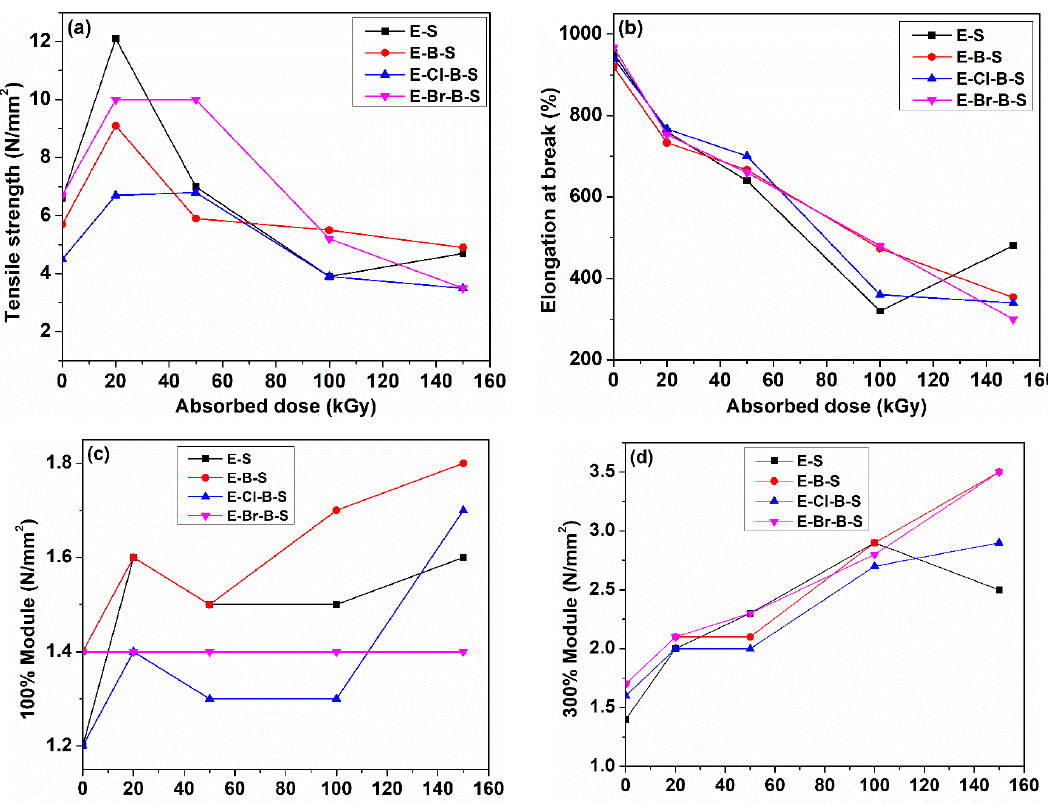
Figure 2. Tensile properties of EPDM composite against the electron irradiation dose: ( a ) tensile strength, ( b ) elongation at break, ( c ) 100% modulus, ( d ) 300% modulus.